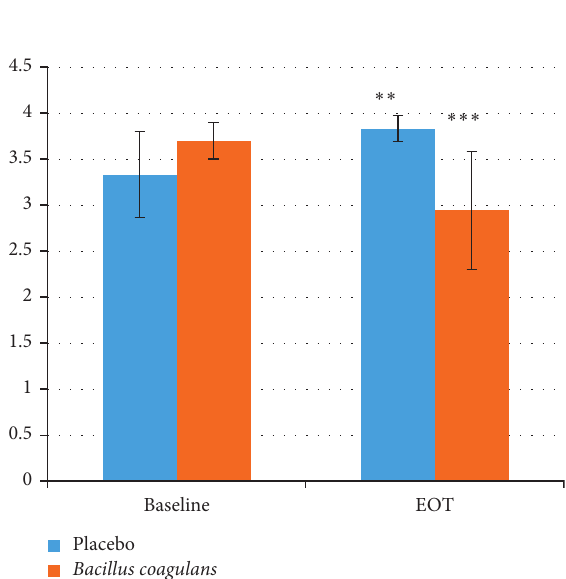
Figure 4: Salivary lactobacilli scores at baseline and EOT. Values